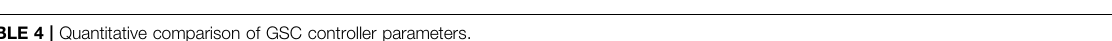
TABLE 4 | Quantitative comparison of GSC controller parameters. Object Point Analysis results